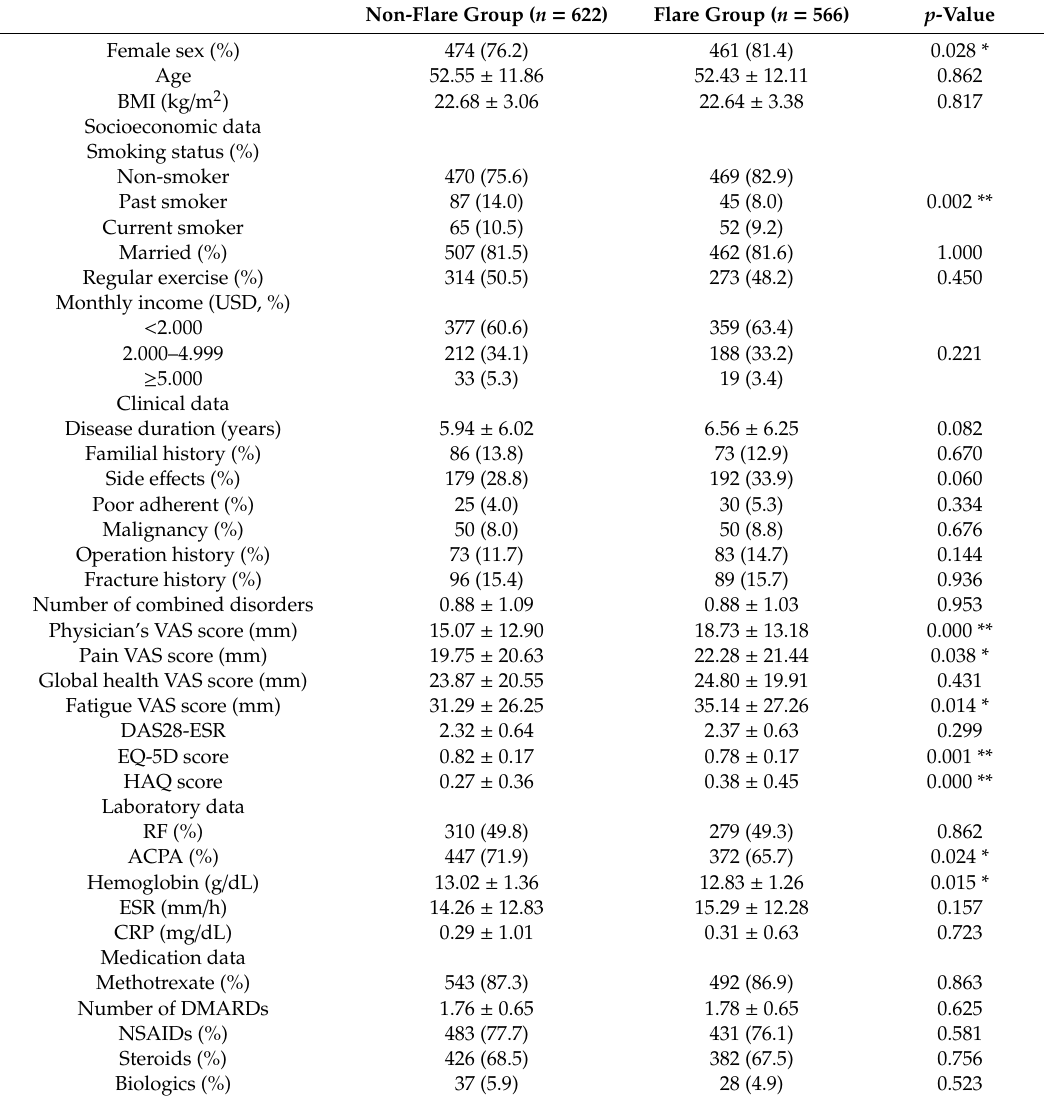
Table 1. Baseline characteristics of non-flare and flare